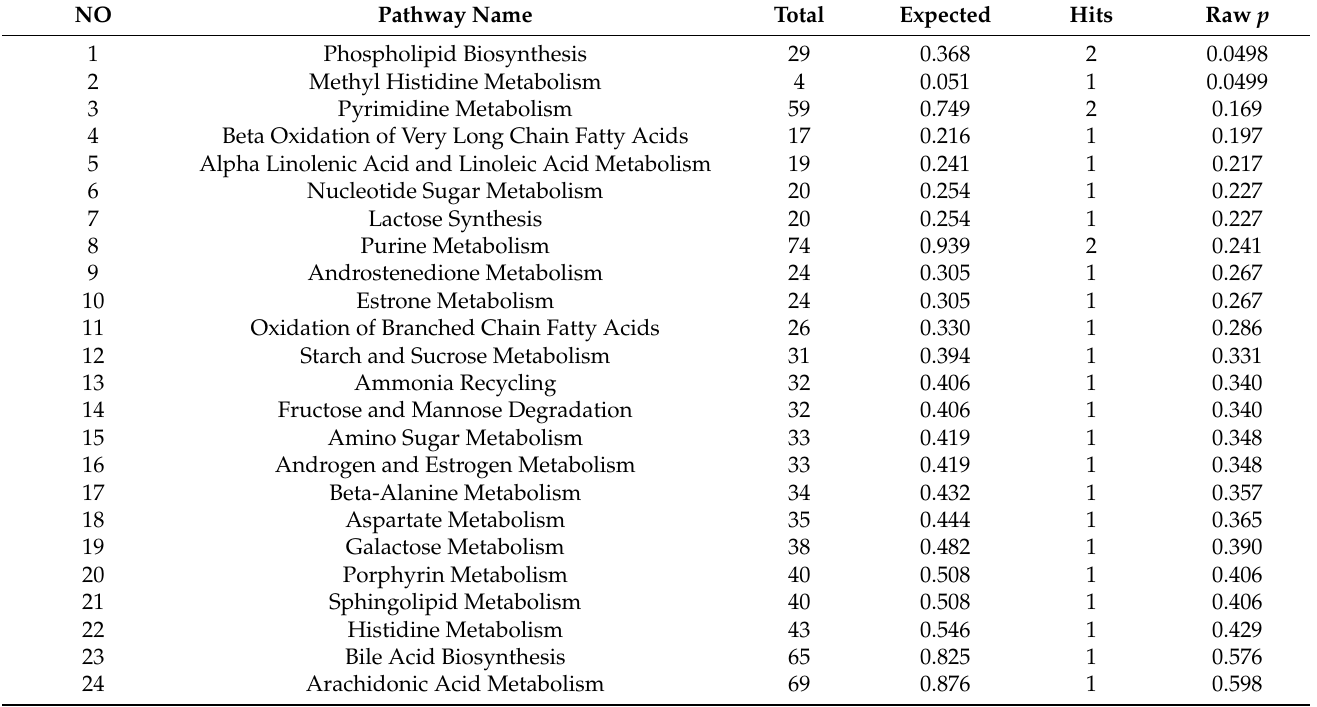
Table 2. Statistical analysis results of the main metabolites in 4T1 cells.